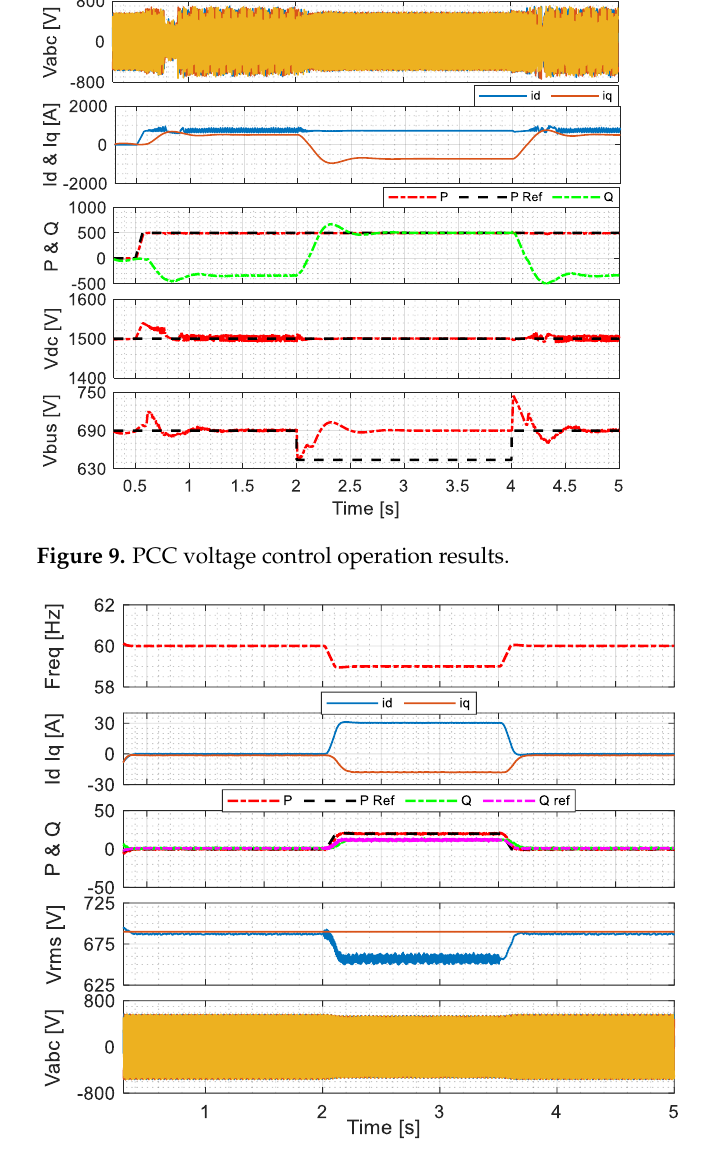
Figure 10. PCC voltage control operation results.